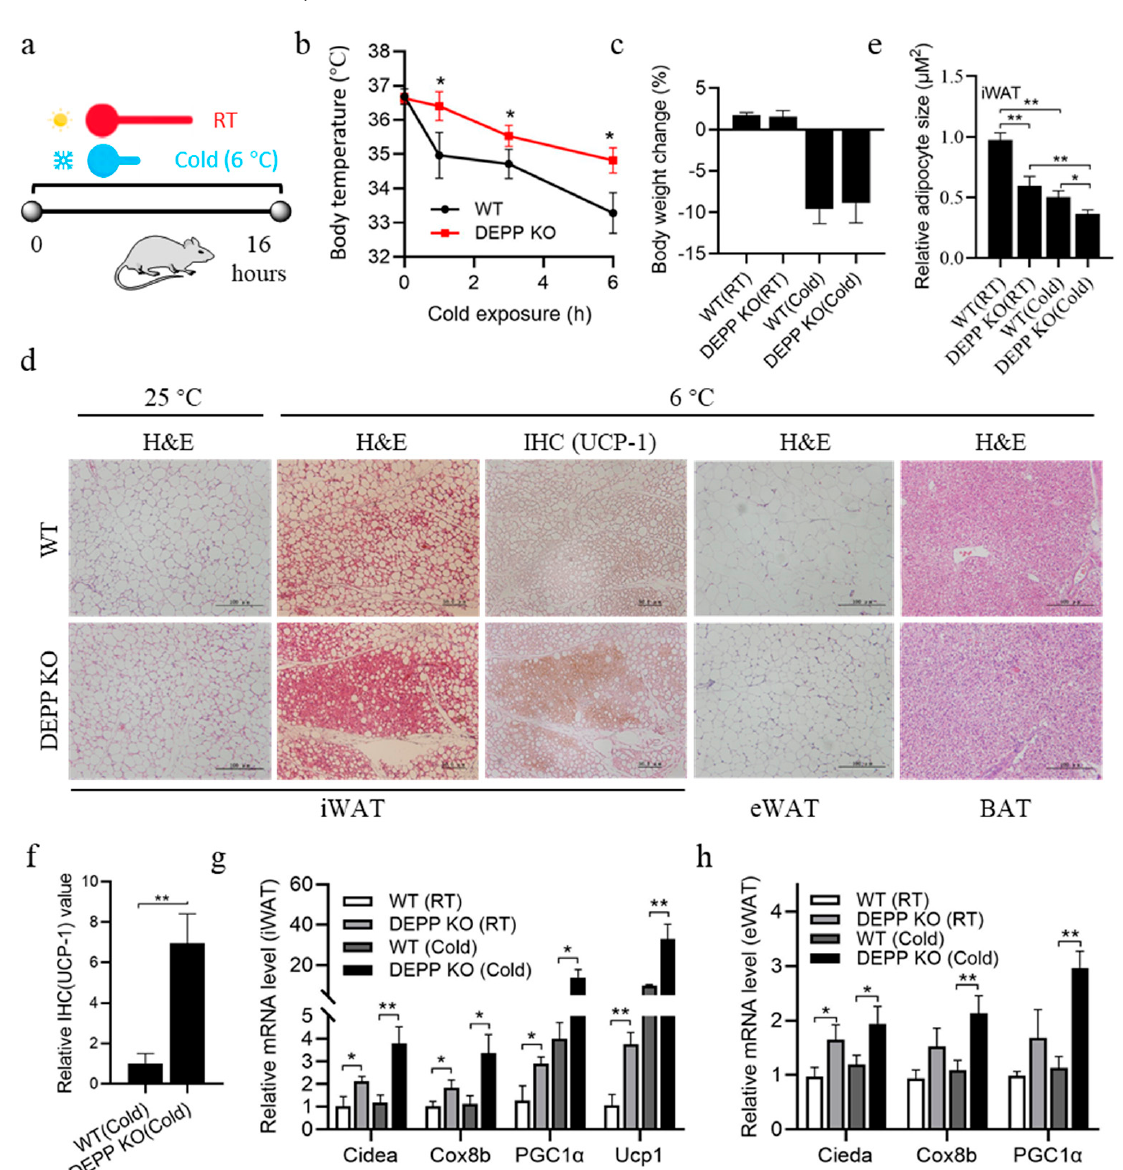
Figure 3. Cold exposure stimulated more browning of WAT in DEPP KO mice than in WT